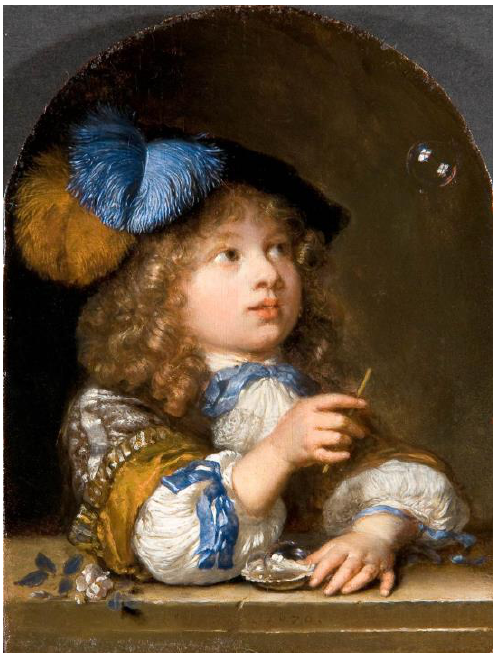
Figure 10. Caspar Netscher, Boy Blowing Bubbles , 1670, Mauritshuis.